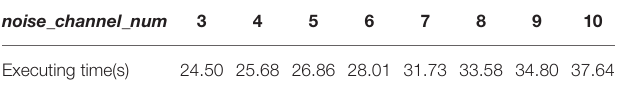
TABLE 4 | The relationship between noise _ channel _ num and executing time. noise _ channel _ num